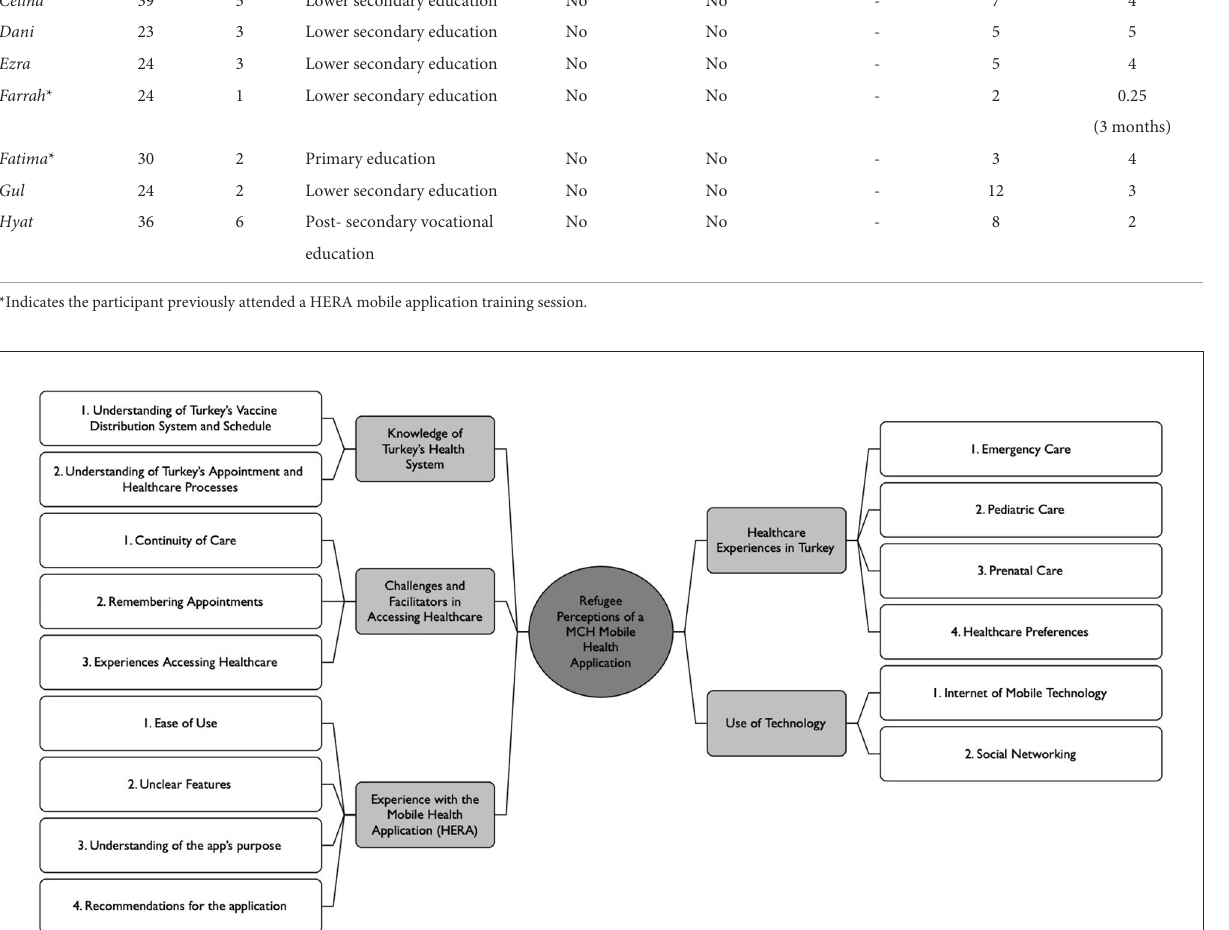
“...Most Syrian women are suffering from depression because they usually give birth alone, they do not have their mothers with them, they do not have their sisters with them. They feel alone, they feel tired of their children and their husbands. I felt very depressed after I gave birth.” (Hyat,